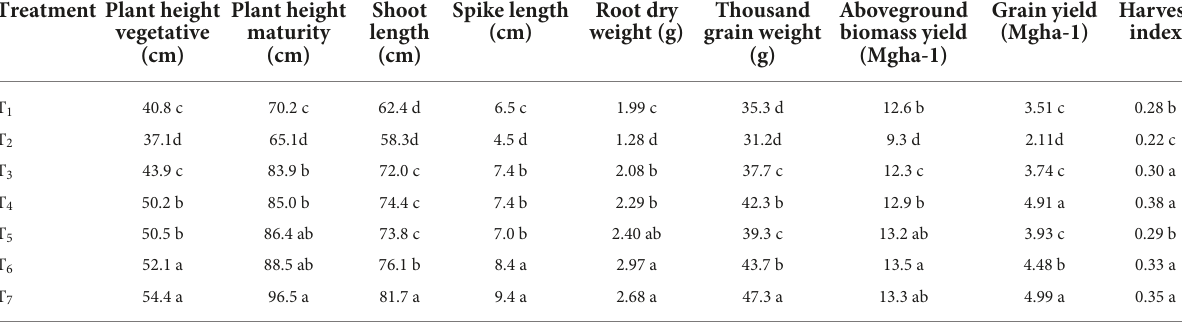
TABLE 2 Wheat physical parameters under different doses of Zn application. Treatment Plant height